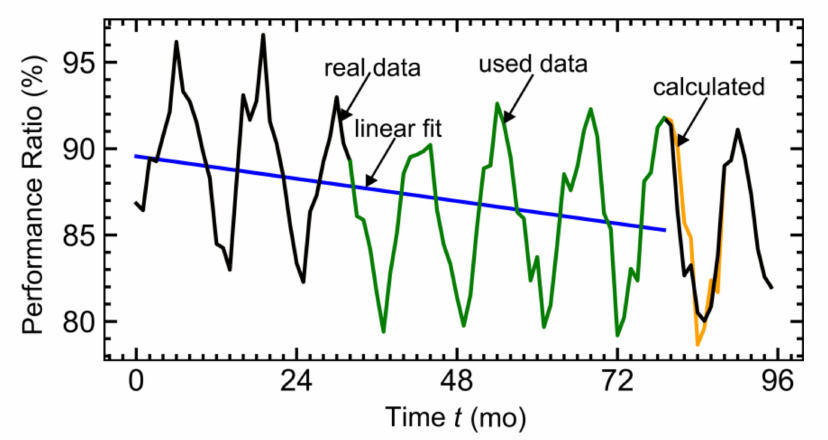
Figure 3. Monthly PR time series reconstructed using the time series reconstruction and imputation algorithm. The black, orange and green plots depict the real, reconstructed and used for the reconstruction data sets,